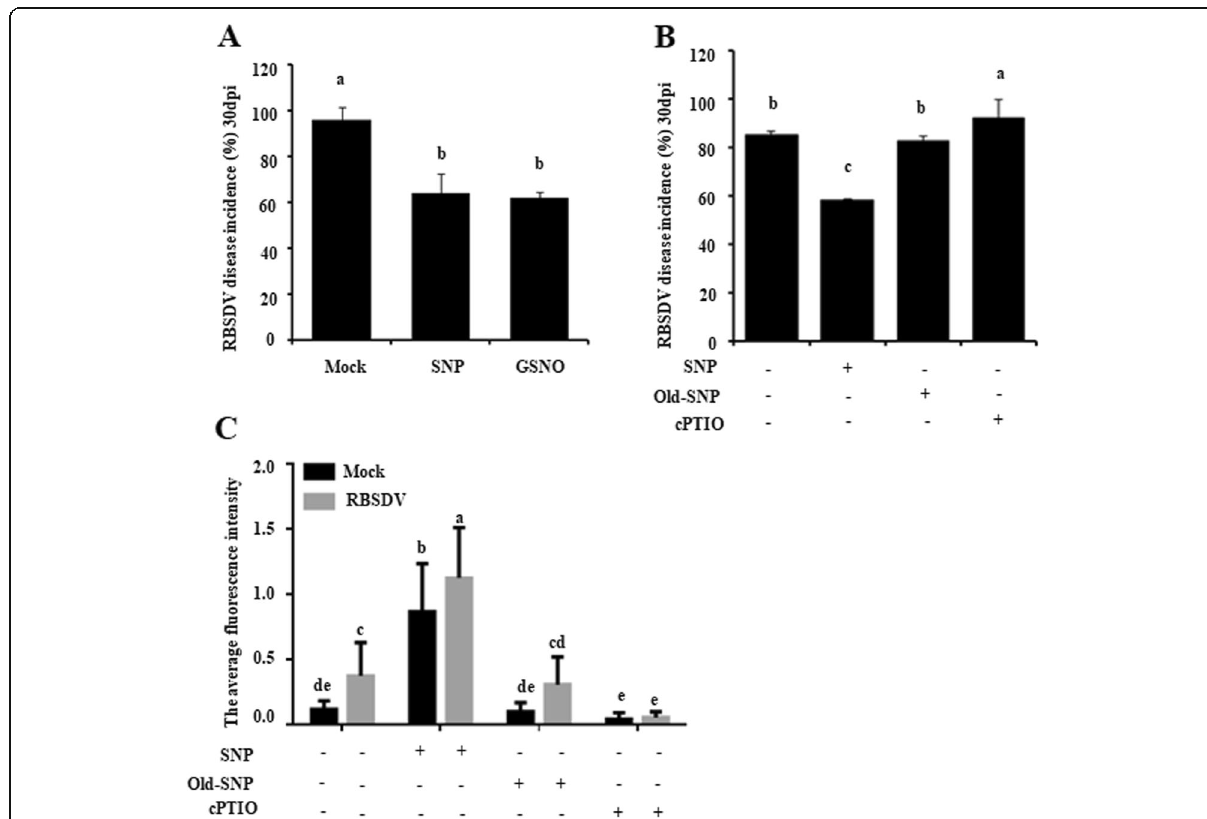
Fig. 3 Changes in Nipponbare rice resistance to RBSDV infection in response to NO-releasing reagents or NO scavenger. a RBSDV disease incidence of the 50 μ M SNP or GSNO pre-treated rice. RBSDV inoculation was carried out using RBSDV viruliferous or non-viruliferous SBPHs. Results were from three independent experiments with 30 plants per treatment. The data represented the means ± SD of the three replicates. b RBSDV disease incidence of the 50 μ M SNP or old SNP, or 100 μ M cPTIO pre-treated Nipponbare rice. Plants pre-treated with water only were used as controls. RBSDV disease incidences were determined at 30 dpi. Results were from three independent experiments with 30 plants per treatment. The data represented the means ± SD of the three replicates. c NO production in the stems of the SNP-, old SNP- or cPTIO pre-treated mock- or RBSDV-inoculated Nipponbare plants. Stem sections with about 3mm thick, were stained with DAF-FM DA, and examined and imaged under a confocal laser scanning microscope. Then, the signal representing NO production in stems was captured and analyzed using the ZEN software. Ten plants were analyzed as ten biological replicates per treatment. The data represented the means ± SD of the ten replicates. Entire experiment repeated 3 times with similar results. Different low case letters above the bars indicate the statistical differences between the treatments, by using the Duncan ’ s multiple